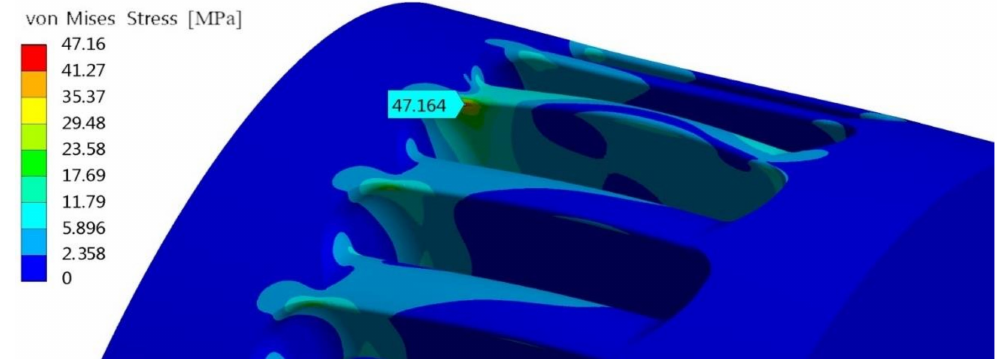
Figure 17. von Mises stress for impeller 2.